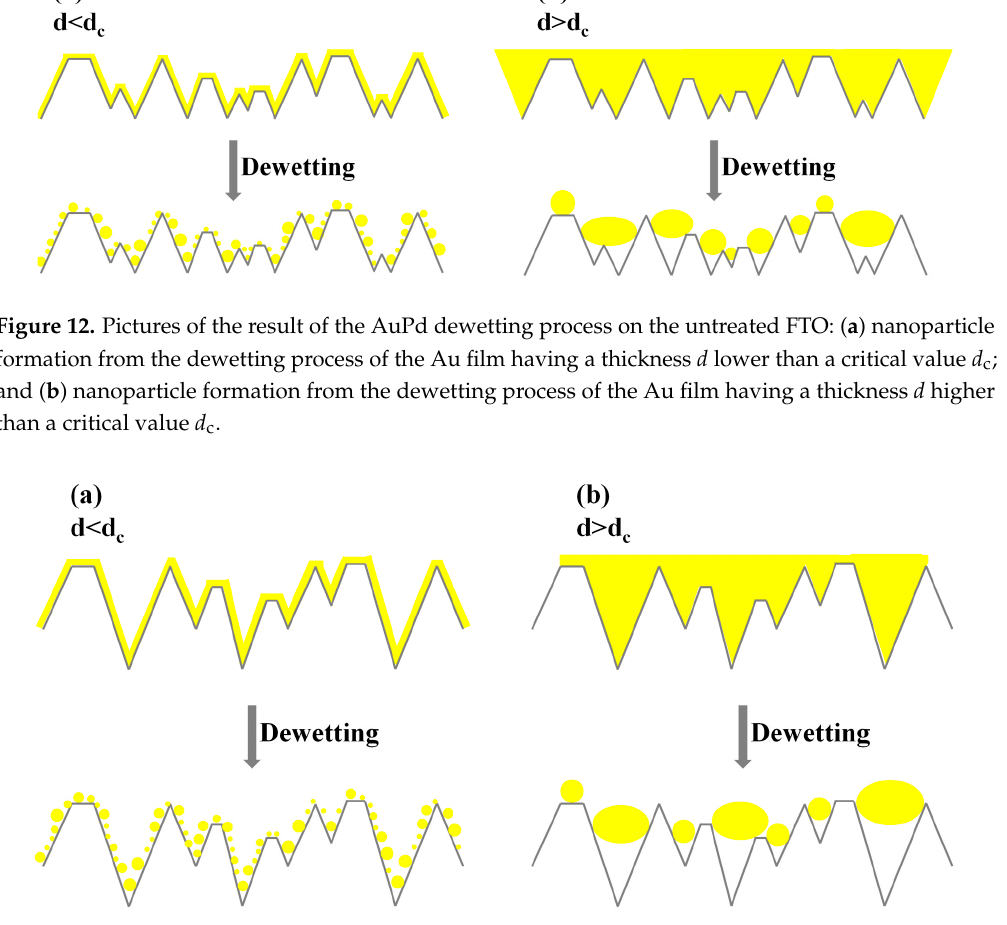
Figure 13. Pictures of the result of the AuPd dewetting process on the textured FTO: ( a ) nanoparticle formation from the dewetting process of the Au film having a thickness d lower than a critical value d c ; and ( b ) nanoparticle formation from the dewetting process of the Au film having a thickness d higher than a critical value d c .